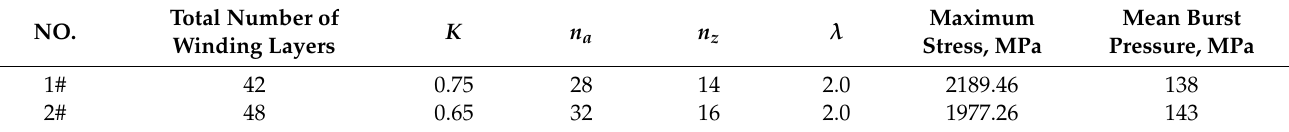
Table 2. Design parameters and test results of COPVs 1# and 2#.